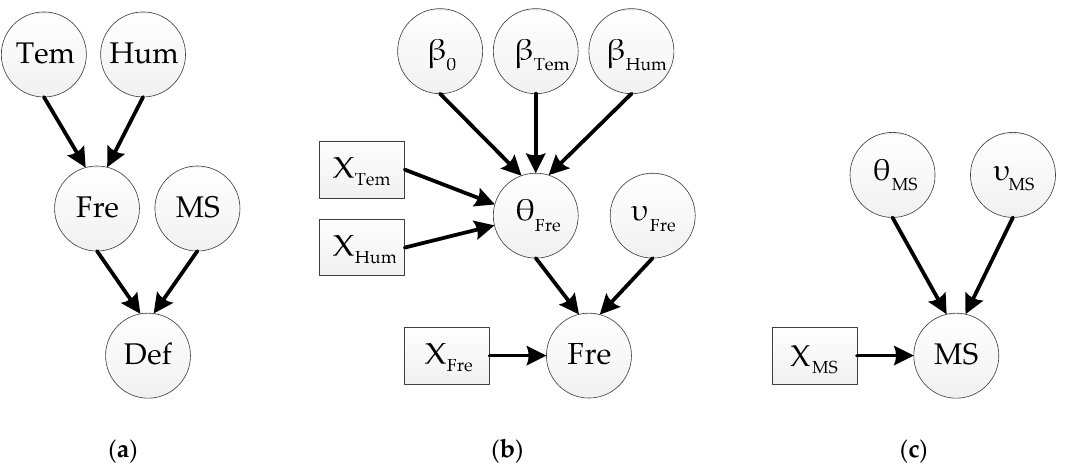
Figure 2. Static BN models: ( a ) Basic BN of deflection analysis with considering main influence factors; ( b ) BN of modal frequency; ( c ) BN of mode shape.